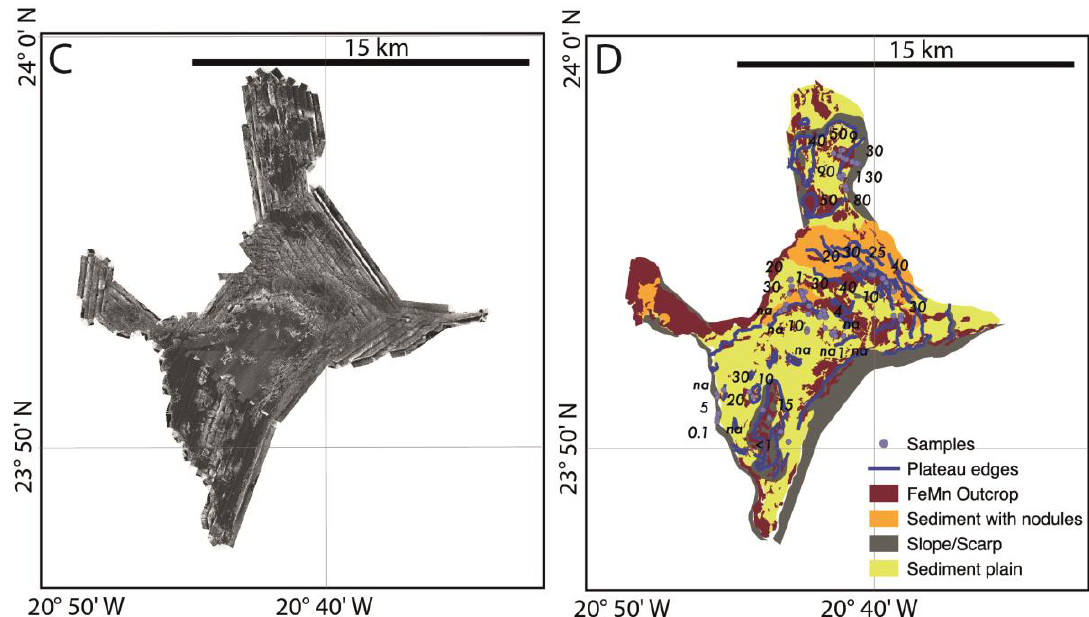
Figure 1. ( A ) Regional setting. Bathymetry data is taken from GEBCO [27]. The black square shows the location of panel B; ( B ) EM120 data collected off Tropic Seamount, gridded at 50 m, overlaid on the GEBCO background. The three sample locations are shown with red dots; ( C ) autonomous underwater vehicle (AUV) side-scan sonar data collected by the AutoSUB6000. Pixel size is 2 m, bright colors represent areas of high backscatter; ( D ) Simplified geological map of the summit from side-scan sonar, bathymetry, and remotely operated vehicle (ROV) groundtruthing. The numbers represent crustal thicknesses measured on samples collected during the ROV dives in mm. na is given where there was no FeMn material on the sample. The FeMn crustal outcrop is mapped in maroon. Nodules were generally sparse in the areas where they were found and are not included in the calculations. The map was produced using QGIS 3